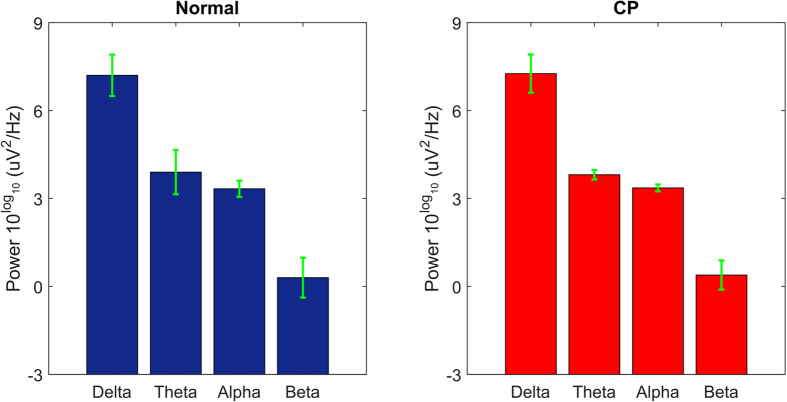
A comparison between the power spectral distributions of the four EEG electrodes recorded from normal rats (left side) and CP rats (right side).Frequencies are divided into four EEG bands: Delta (1–4 Hz), Theta (4–8 Hz), Alpha (8–12 Hz), Beta (13–25 Hz). The statistical analysis did not reveal any significant difference between the whole two distributions (P = 0.320, two-sample Kolmogorov-Smirnov test) and, by compare pair-wisely, each band (P > 0.1 in all ranksum tests).